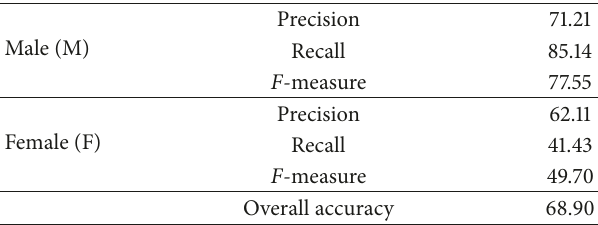
Table 6: Performance results for gender classification on KHATT